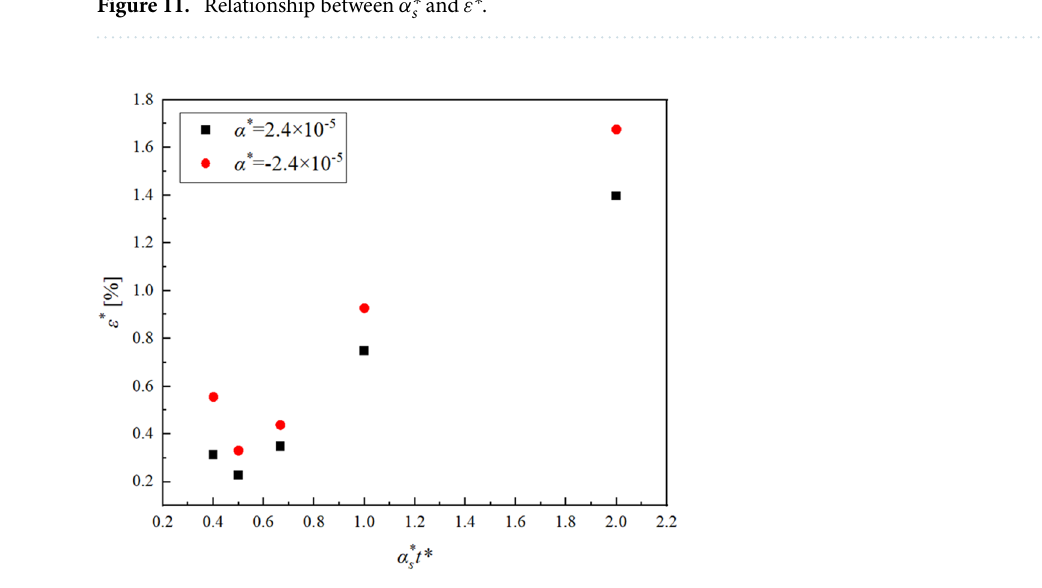
Figure 12. Relationship between α ∗ s t ∗ and ε ∗ .